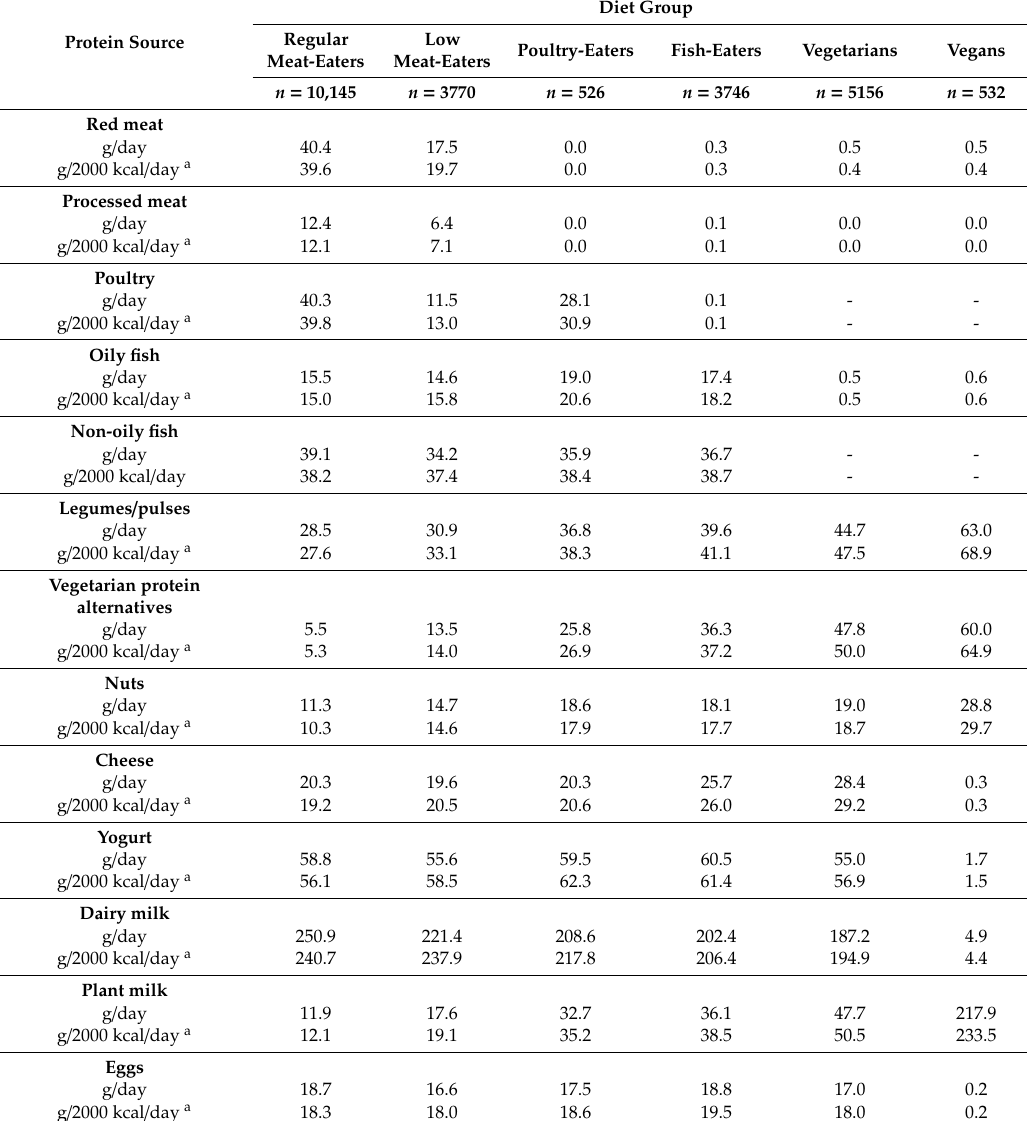
Table 3. Major protein-source food intakes in EPIC-Oxford